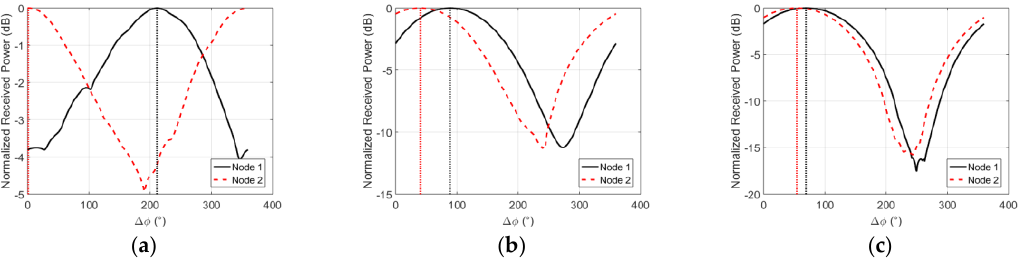
Figure 14. Normalized received power on the power-combined on-body arrays in three studied scenarios shown in Figure 8 g to h. ( a ) On-body beam steering scenario 1 ( b ) On-body beam steering scenario 2 (b) On-body beam steering scenario 3.